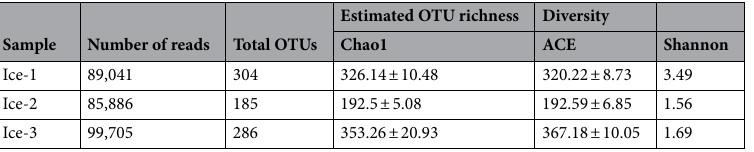
Table 3. Number of reads, OTUs, taxon richness and diversity indexes for cave ice samples.